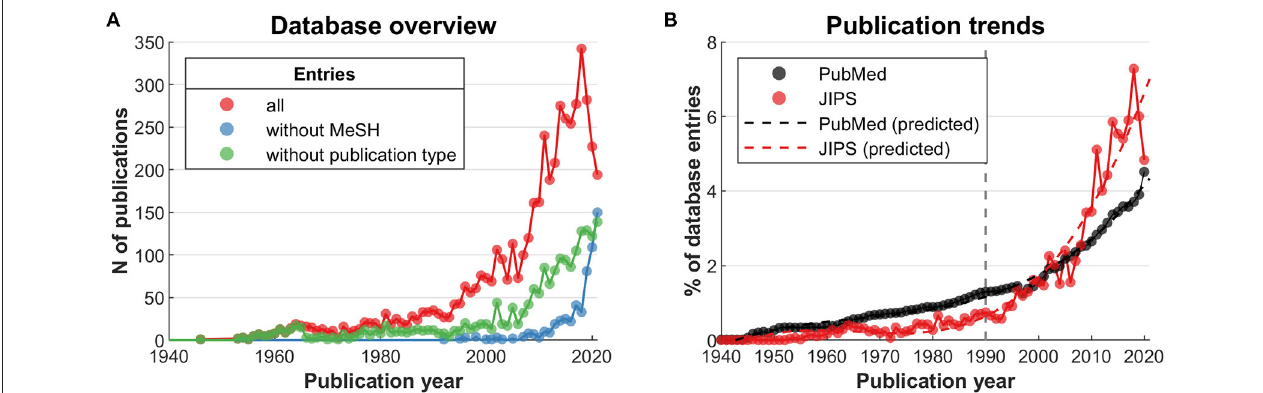
FIGURE 1 | JIPS database overview compared to all PubMed publications. The gray vertical line marks the introduction of the “placebo effect” MeSH term (1990). (A) Number of all publications in the JIPS database (red line). Of these, a number of publications have not been MeSH-indexed at the time of data compilation (blue line), with a higher number in the most recent years. Likewise, a number of publications do not have an informative Publication Type (green line). See text for details. (B) Publications in the entire PubMed database compared to the JIPS database, normalized by total database volumes. The JIPS trajectory (red dashed line) first undercuts the PubMed trajectory (black dashed line), then exceeds it around year 2001. Predicted values from random intercept linear mixed effects model with quadratic